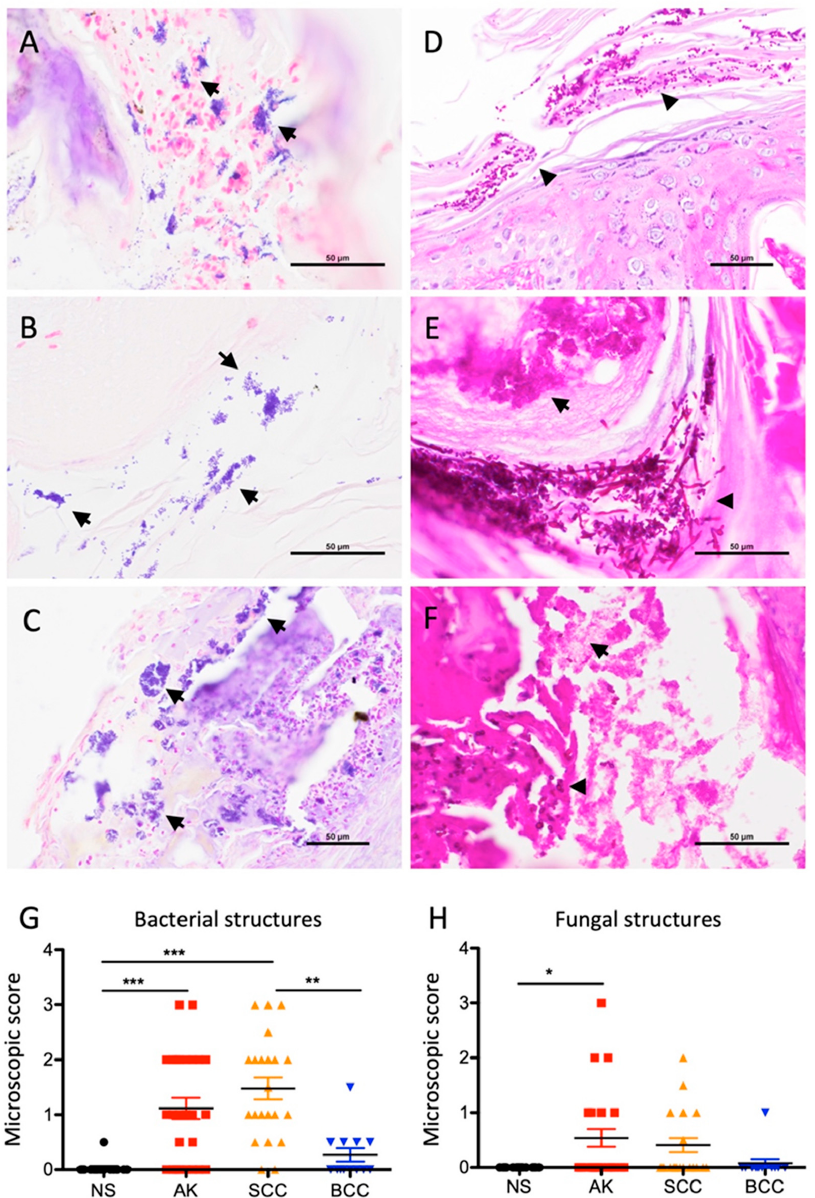
Figure 1. Abundant microbial structures are prevalent in actinic keratosis (AK) and squamous cell carcinoma (SCC). ( A – F ) Bacterial (arrows) and fungal (arrow heads) structures in AK ( A , D , E ) and SCC ( B , C , F ) specimens ( A – C , Gram stain; D – F , PAS stain). ( G ) Microscopic scoring indicates significantly increased bacterial structures in AK and SCC compared to basal cell carcinoma (BCC) and NS (normal skin) samples (** p < 0.01; *** p < 0.005; Kruskal–Wallis test; Dunn’s multiple comparison test). ( H ) Slightly increased fungal structures in AK samples (* p < 0.05; Kruskal–Wallis test; Dunn’s multiple comparison